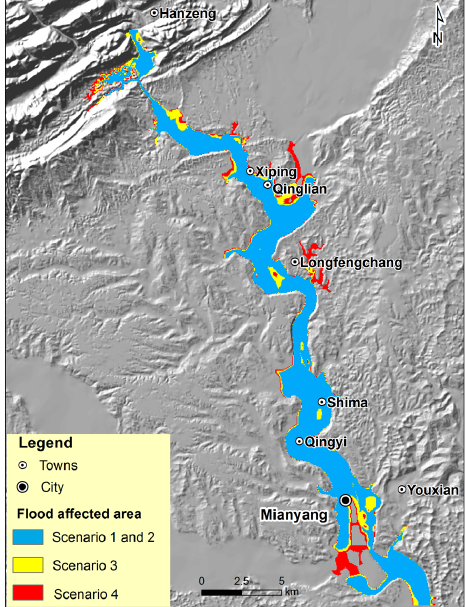
Fig. 14. Modelled flooded area for different scenarios. The yellow and red areas represent the increase in flooded area for Scenario 4 and 5, respectively.